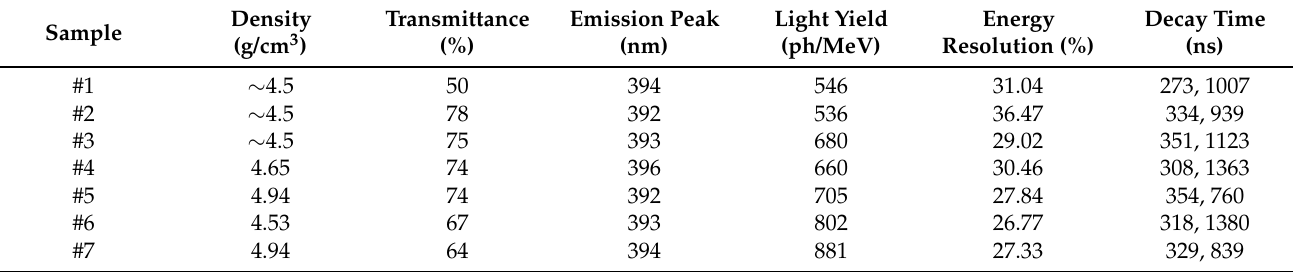
Table 1. Characterization results of samples #1–#7 of scintillating